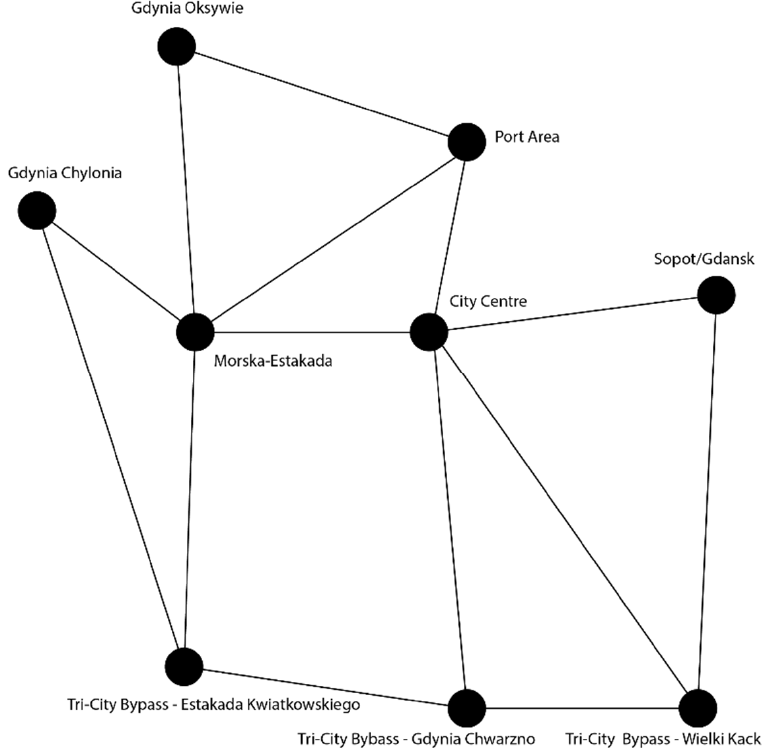
Figure 11. Graph theory model of the analysed road network in Gdynia.